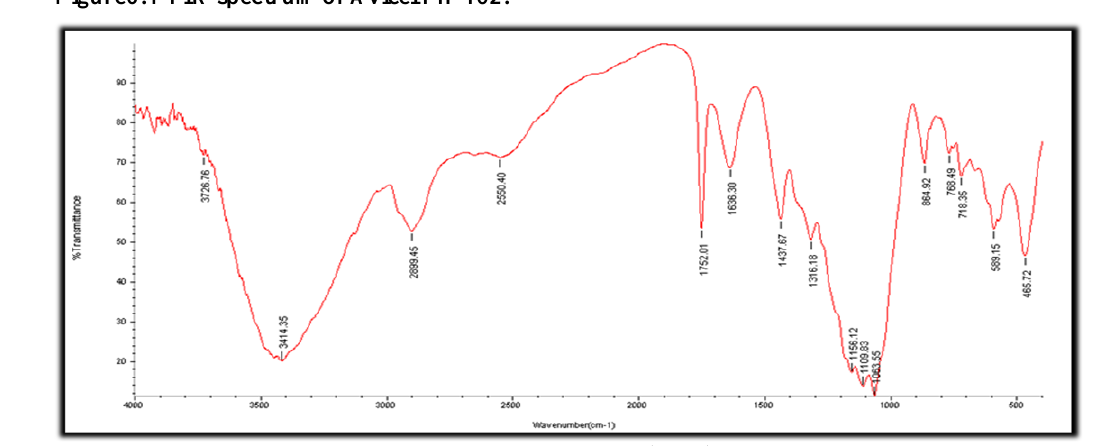
Figure 7. FTIR spectrum of directly compressed tablet (DCT)